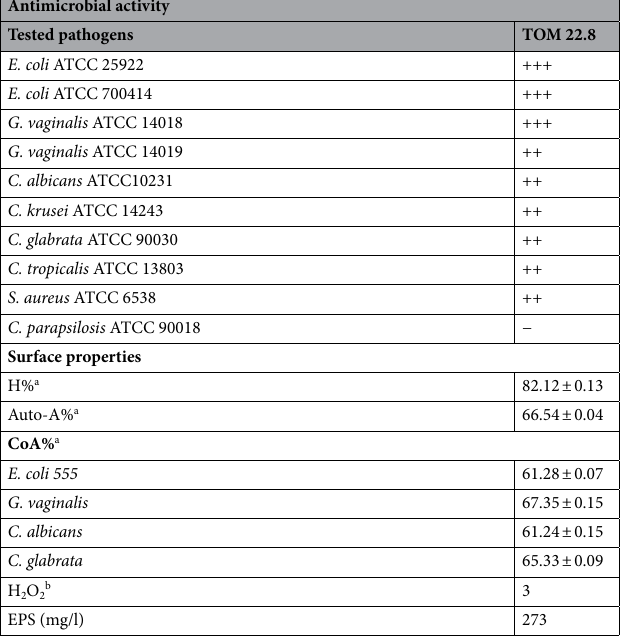
Table 2. Antimicrobial activity against pathogens, surface properties, hydrogen peroxidase (H 2 O 2 ) and exopolysaccharide (EPS) production exhibited by the L. rhamnosus TOM 22.8 strain. (−) no inhibition zone, (+) inhibition zone < 10 mm; (++) inhibition zone 11–20 mm; (+++) inhibition zone > 20 mm. a Results of surface properties (H%: hydrophobicity; auto-A%: auto-aggregation; CoA%: co-aggregation) are expressed as average percentage value and standard deviation of three separate experiments. b Results of H 2 O 2 production was scored as: 0, (absent, no production of blue coloration); 1 (low production, time > 20 min), 2 (medium production, time 10–20 min), and 3 (high production, time < 10